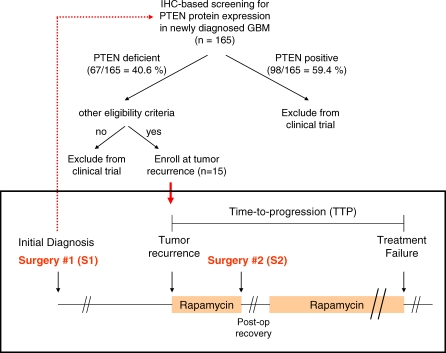
Clinical Trial DesignEnrollment in the Phase I clinical trial was restricted to patients whose initial tumor resection (“surgery 1”) specimen was PTEN-deficient by immunohistochemistry. Patients were enrolled after failing standard therapy with radiation and chemotherapy (i.e., “tumor recurrence”). Prior to the scheduled salvage tumor resection (“surgery 2”), patients received a short course (mean: 7.5 d) of oral rapamycin. Rapamycin was resumed after recovery from surgery until patients developed clinical and/or radiographic evidence of treatment failure. The effects of rapamycin on tumor cell proliferation and mTOR signaling in tumor tissue were determined by comparing the tumor tissue collected during salvage resection (“surgery 2”) with a sample of the same tumor collected during the initial tumor resection (“surgery 1”). Time-to-progression (TTP) was defined as the interval between start of rapamycin therapy and postoperative treatment failure.